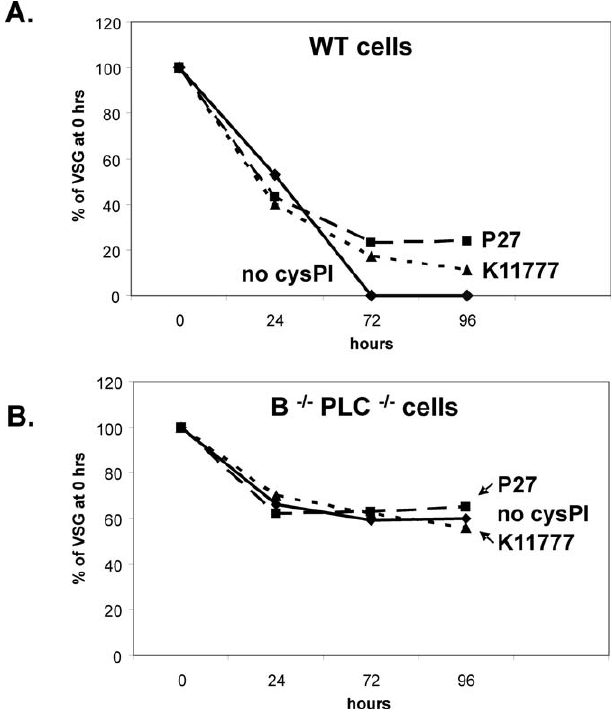
Figure 11. VSG Levels during BSF-to-PRO Differentiation in the Presence of Cysteine Protease Inhibitors WT (A) and B (cid:2) / (cid:2) PLC (cid:2) / (cid:2) (B) BSF cells were stimulated to differentiate to PRO cells as described except that 2 l M concentrations of the inhibitors P27 and K11777 were either added or not added (no cysPI) to the PRO differentiation medium at time 0. Cells were collected at the indicated times and extracts analyzed by western blots for VSG and tubulin, similar to the blots shown in Figure 6B and 6E. VSG levels were quantitated at each time point, the VSG intensities were normalized to the tubulin levels, and the initial VSG levels (0 h) were set at 100%, similar to that shown in Figure 7. The VSG level shown for each time point is a percentage of initial VSG level. In WT cells (A), P27 and K11777 interfere with the loss of about 20% and 10% of the VSG, respectively, at 96 h, whereas in B (cid:2) / (cid:2) PLC (cid:2) / (cid:2) cells (B) the cysteine protease inhibitors do not have a detectable effect.